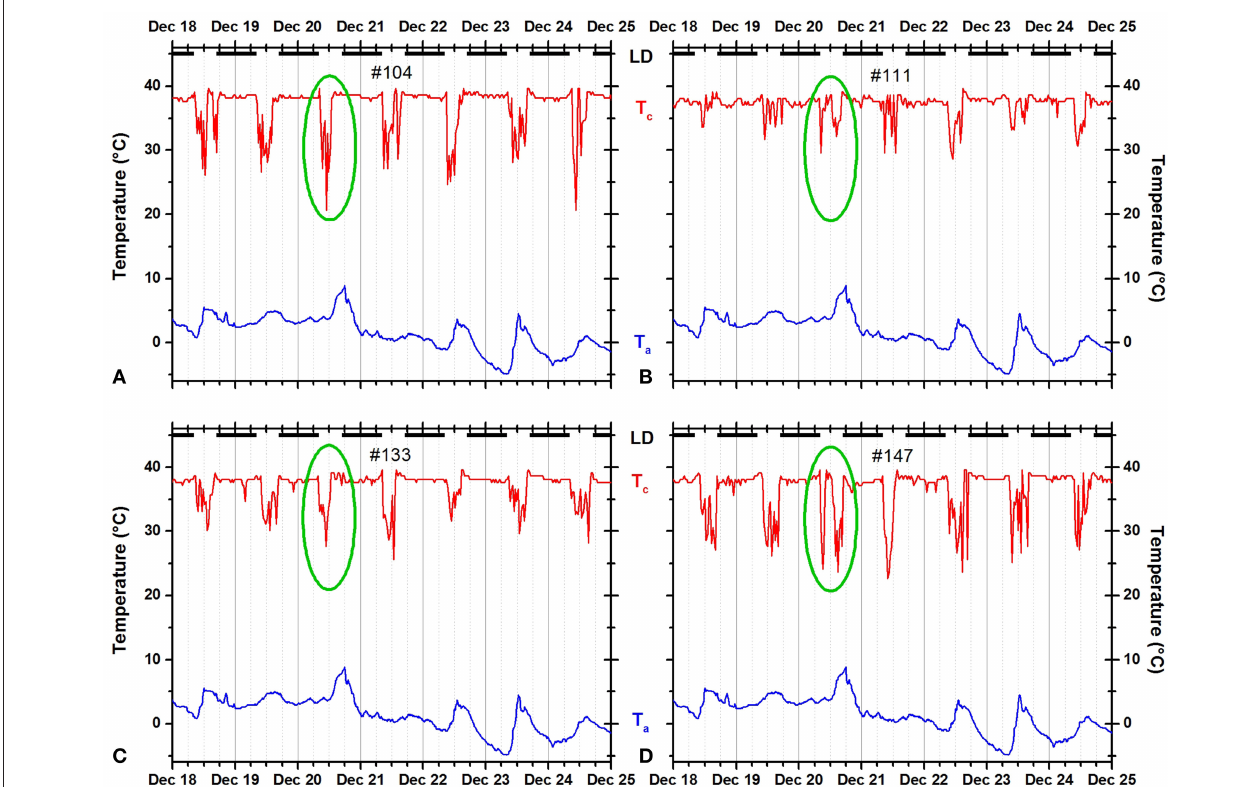
FIGURE 2 | Records of ambient temperature (T a , blue) and neck skin temperature (T c , red) for four fox squirrels 104 (A) , 111 (B) , 133 (C) , and 147 (D) living outdoors during the winter. The dark horizontal bars at the top of each panel indicate the duration of the dark phase of the natural light–dark cycle. The green ovals mark the time course of body temperature at the same day illustrating individual variability under the same weather conditions. Squirrels 104 and 133 showed a unimodal pattern, whereas squirrels 111 and 147 showed a bimodal pattern.